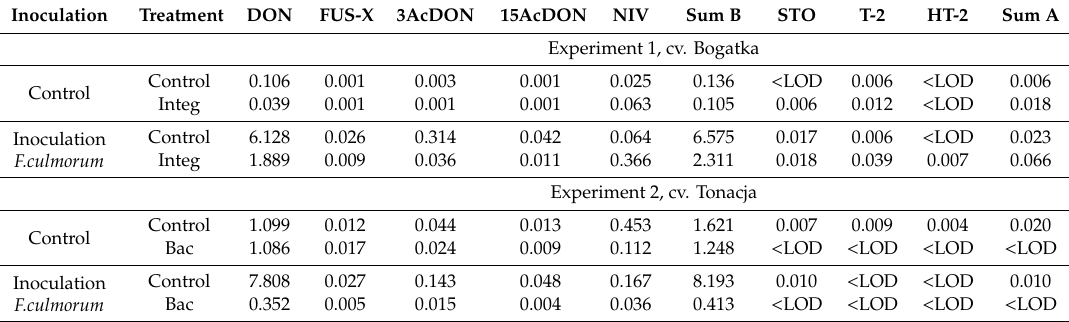
Table 5. Content of Fusarium metabolites in winter grain (mg kg − 1